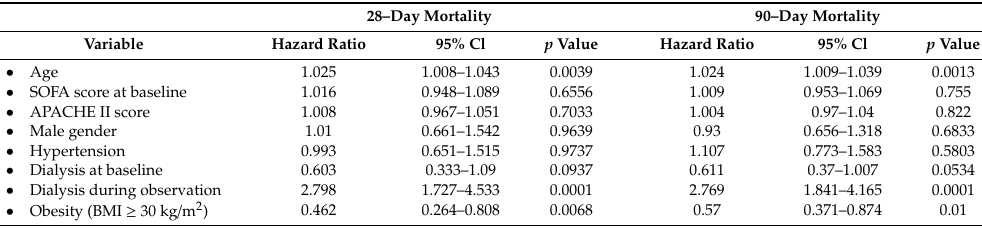
Table 4. Cox regression analysis with respect to obesity